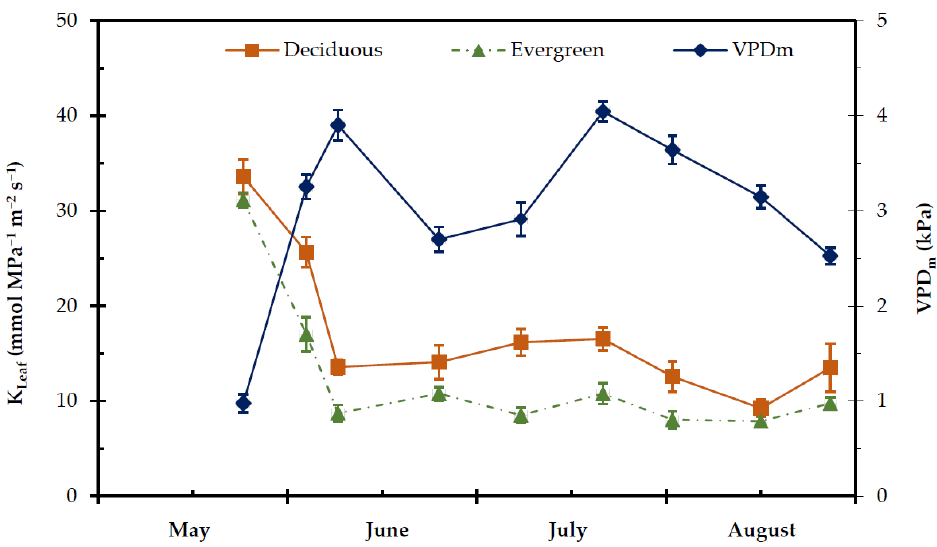
Figure 7. Seasonal midday vapour pressure deficit (VPD m ) and leaf hydraulic conductance (K Leaf ) of the considered deciduous and evergreen shrubs during the experimental period, from 27 May to 28 August. Values are means ± SE (n Kleaf = 24, n VPDm = 48).